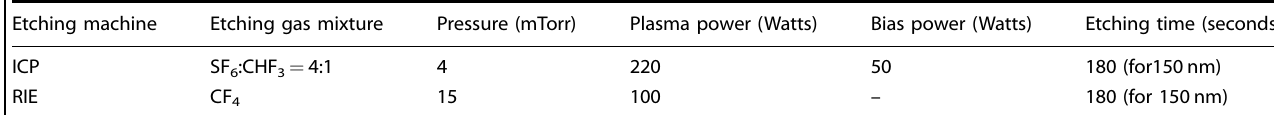
Table 2. The etching parameters for the two etching machines.